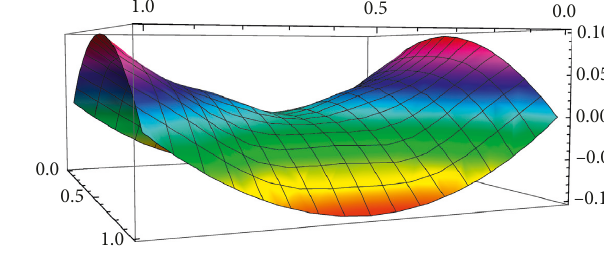
Figure 20: Third order ( t �